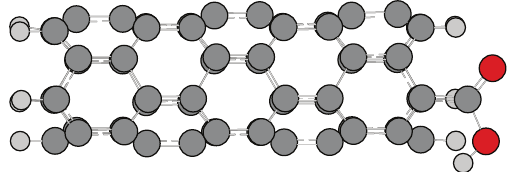
Figure 3: Optimized geometry of the finite (5, 0) zigzag SWCNT (C 60 H 19 ) with the formic acid radical at the tube tip. Gray color depicts carbon atoms; light gray is hydrogen and red is